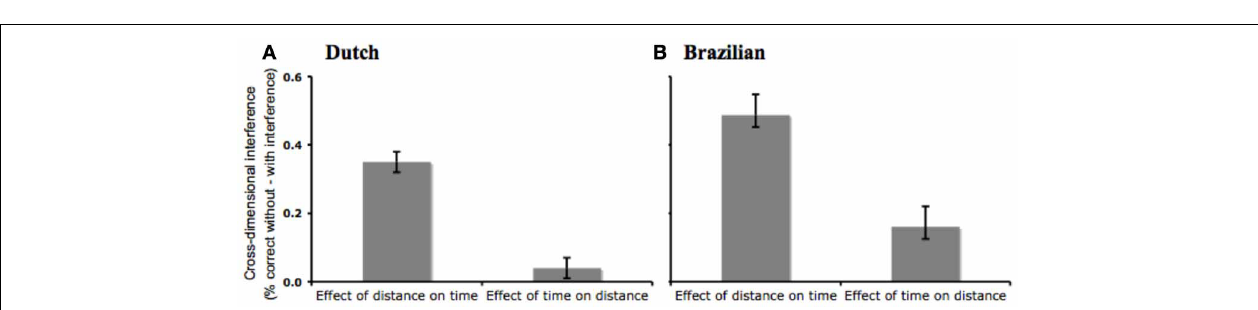
FIGURE 2 | Comparison of cross-dimensional interference effects for Dutch (A) and Brazilian (B) children. Error bars indicate s.e.m.